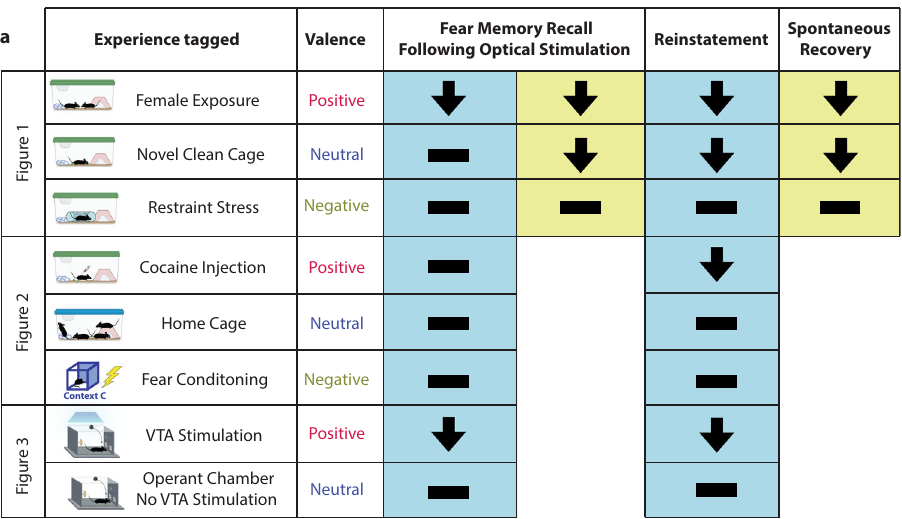
Fig. 8 | The signi fi cance of valence. a Reactivation of a competing positive memory via optical stimulation is suf fi cient to update a fear memory during reconsolidation. Reactivation of an engram associated with a negative experience, or a neutral experience with the exception of exposure to a novel clean cage, was